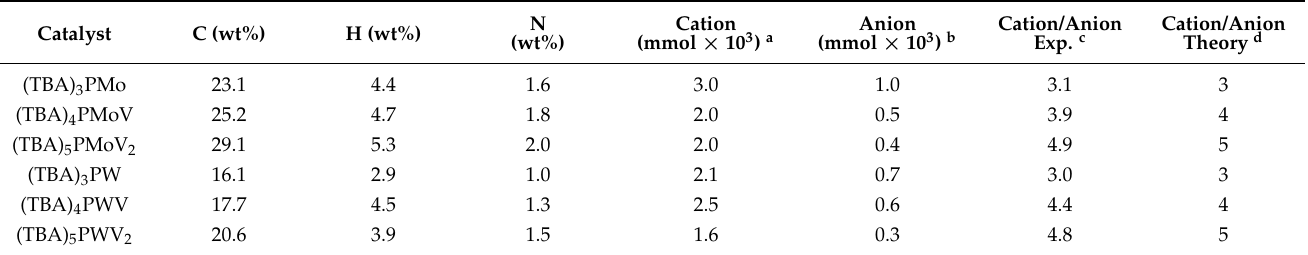
Table A2. CHN analysis of the pure and substituted Mo and W catalysts by elemental analysis.